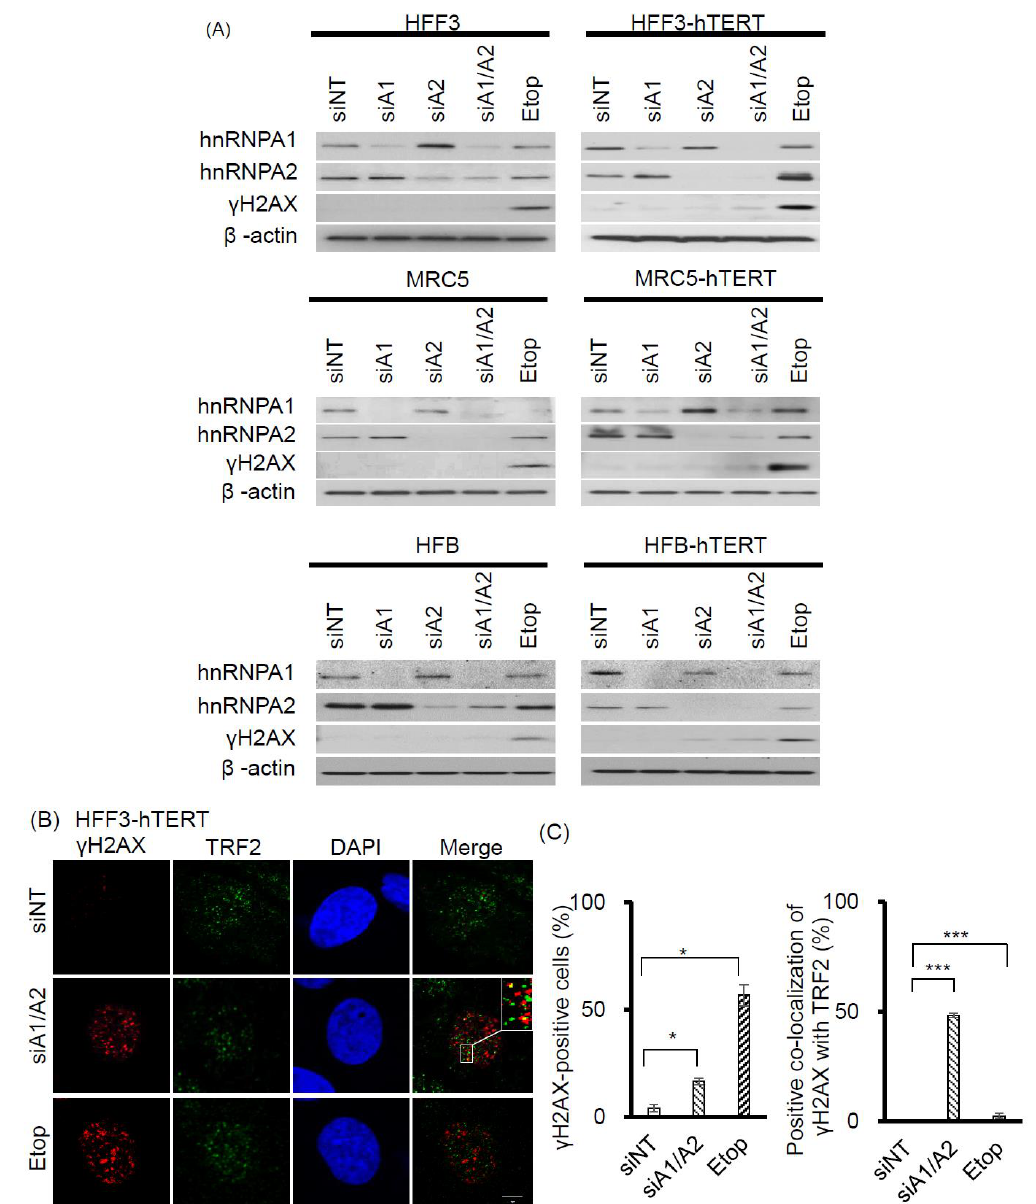
Figure 6. Effects of suppressing hnRNP A1 and/or A2 on DDR in normal fibroblasts and hTERT-immortalized normal fibroblasts. ( A ) Normal fibroblasts (HFF3, MRC5, and HFB) and hTERT-immortalized normal fibroblasts (HFF3-hTERT, MRC5-hTERT, and HFB-hTERT) were transfected with siRNA targeting hnRNPA1 (siA1), hnRNPA2 (siA2), both hnRNP A1 and A2 (siA1/A2), or with a non-targeting sequence (siNT). After 72 h, cell lysates were analyzed for expression levels of hnRNP A1, hnRNP A2, and γ H2AX by Western blotting. β -Actin served as a loading control, and cells treated with 50 µ M etoposide (Etop) for 12 h served as a positive control; ( B ) Transfected HFF3-hTERT cells were fixed and immunostained for γ H2AX (red) and TRF2 (green), and nuclei were counterstained with DAPI (blue). HFF3-hTERT cells treated with 50 µ M etoposide (Etop) for 12 h were included as a control; the scale bar equals 5 µ m. ( C ) The percentage of nuclei positive for γ H2AX staining was determined from analysis of ~100 nuclei from each experiment; the data shown in the left panel are from 2 independent experiments. The percentage of γ H2AX co-localized with TRF2 was determined from analysis of 50 γ H2AX -positive nuclei from each experiment; the results shown in the right panel are from 2 independent experiments. * p < 0.05 and *** p < 0.001 versus siNT